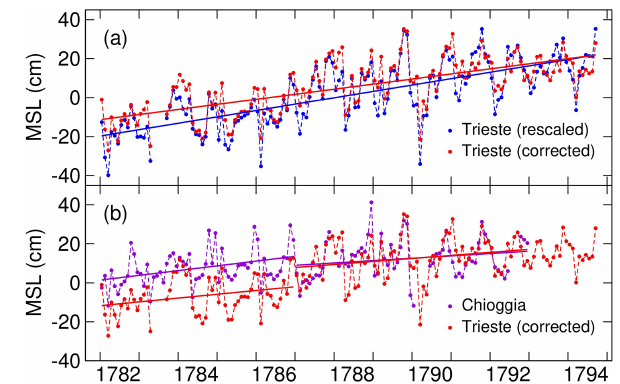
Figure 8. (a) Monthly mean sea levels of Trieste: rescaled heights (blue) and corrected heights (red). (b) Comparison of the monthly mean sea level (MSL) of Trieste (red) and Chioggia (purple). The Chioggia time series was offset so that the 1787–1792 mean sea levels of both stations